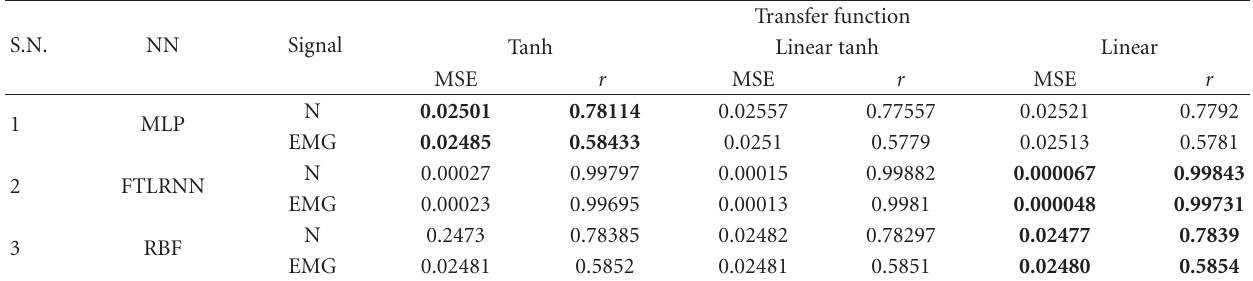
Table 12: Selection of transfer function for various NN models on test dataset.